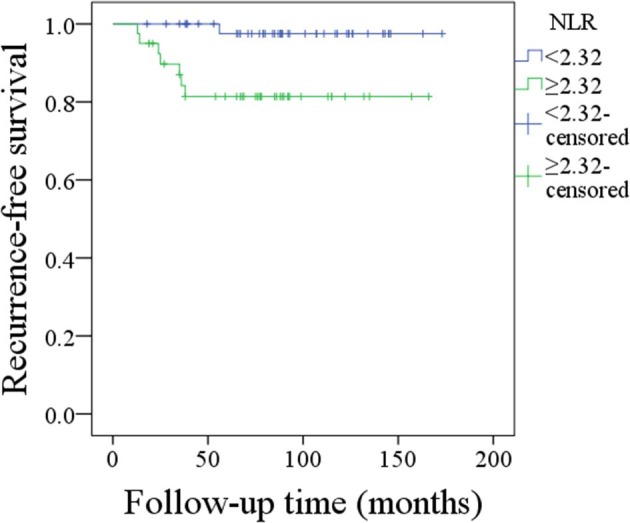
Recurrence-free survival of patients with different neutrophil-to-lymphocyte ratios (p = 0.010).